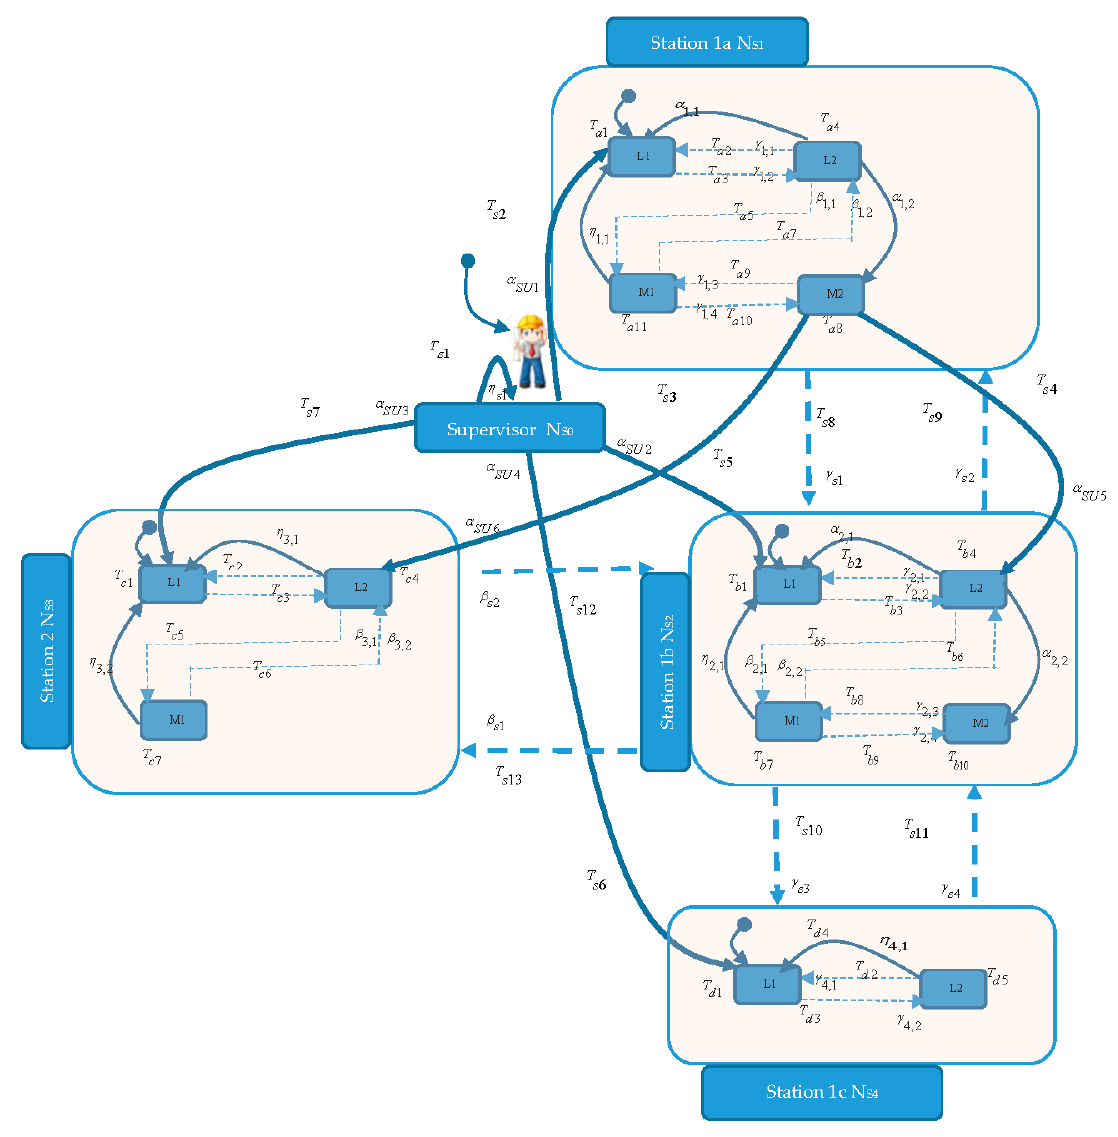
Figure 1. An example of a supervisor model.